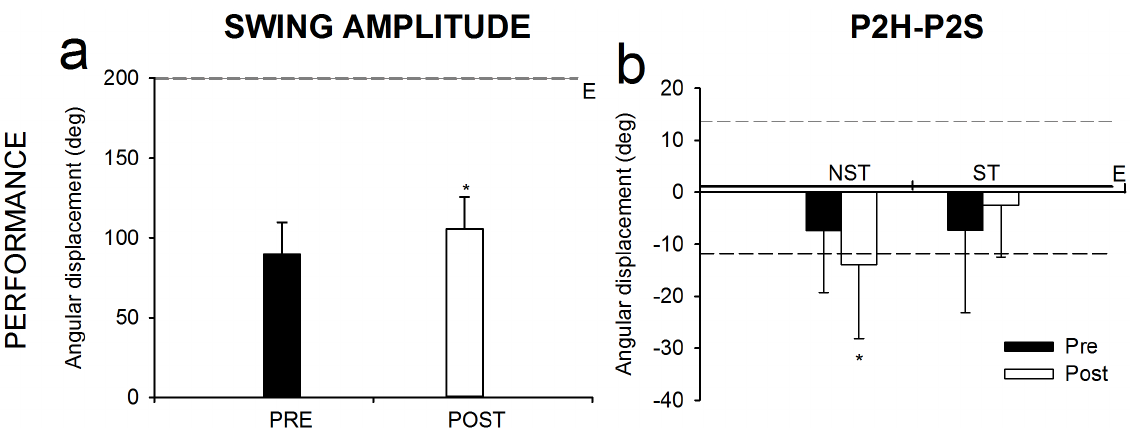
Figure 2. Longswing amplitude and inter-joint reversal point changes after the practice period. Results of the 2 (Group) 6 2 (Time) ANOVA with repeated measures comparing pre- and post-practice skill global index and coordination variables are depicted in (a) longswing amplitude and (b) inter-joint reversal point P2H-P2S. The expert group (E) mean (solid line) and standard deviation (dashed lines) of these variables are provided for comparison. ( w ) indicates significant group or time differences. Interaction effects are not presented for